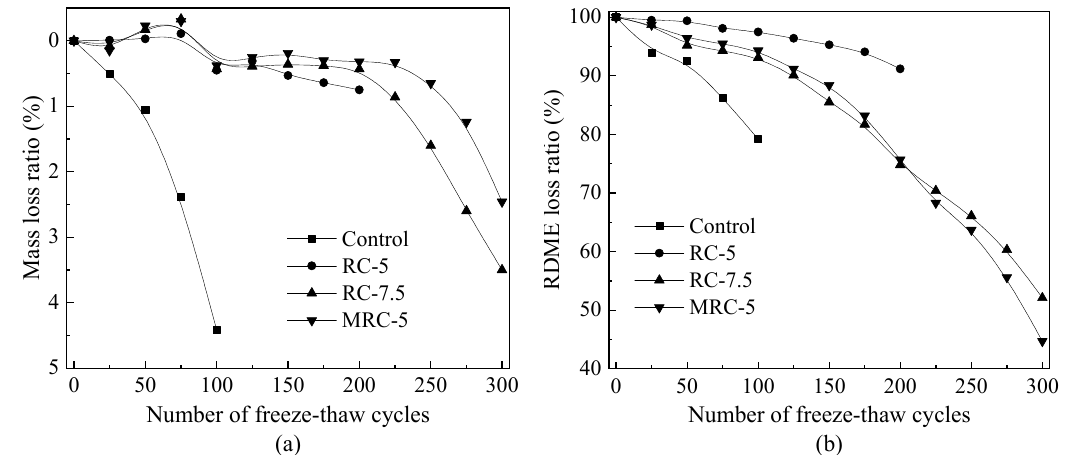
Figure 2. Loss ratios of concrete with rubber ( a ) mass, ( b ) RDME.